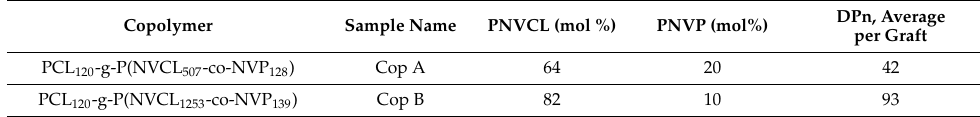
Table 4. Molecular characteristics of the PCL-g-P(NVCL-co-NVP)